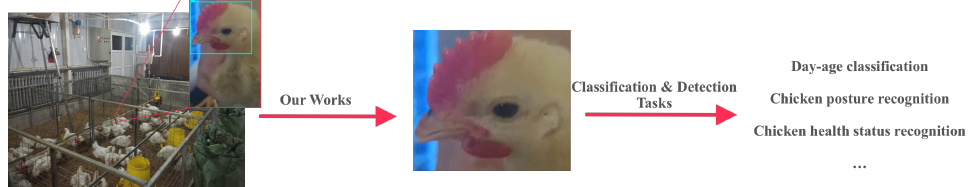
Figure 11. Schematic diagram of the upstream and downstream task network based on the model in this